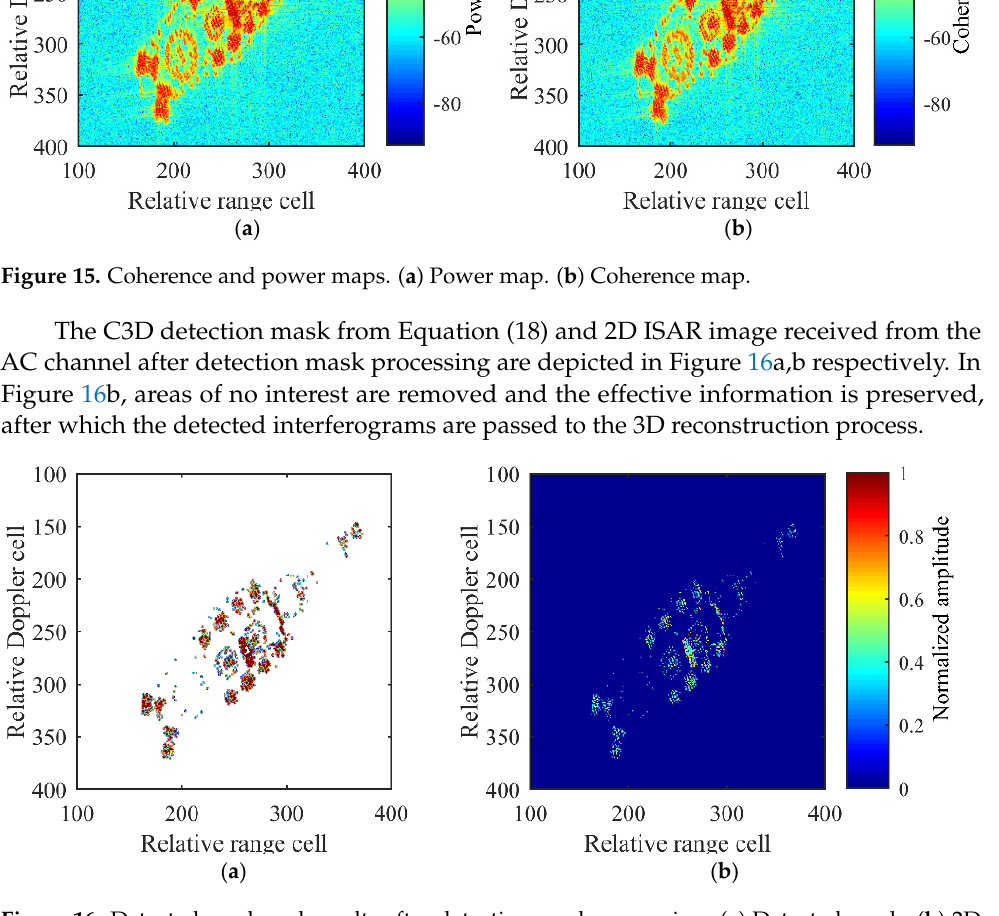
Figure 16. Detected mask and results after detection mask processing. ( a ) Detected mask. ( b ) 2D ISAR image received from the AC channel after detection processing.